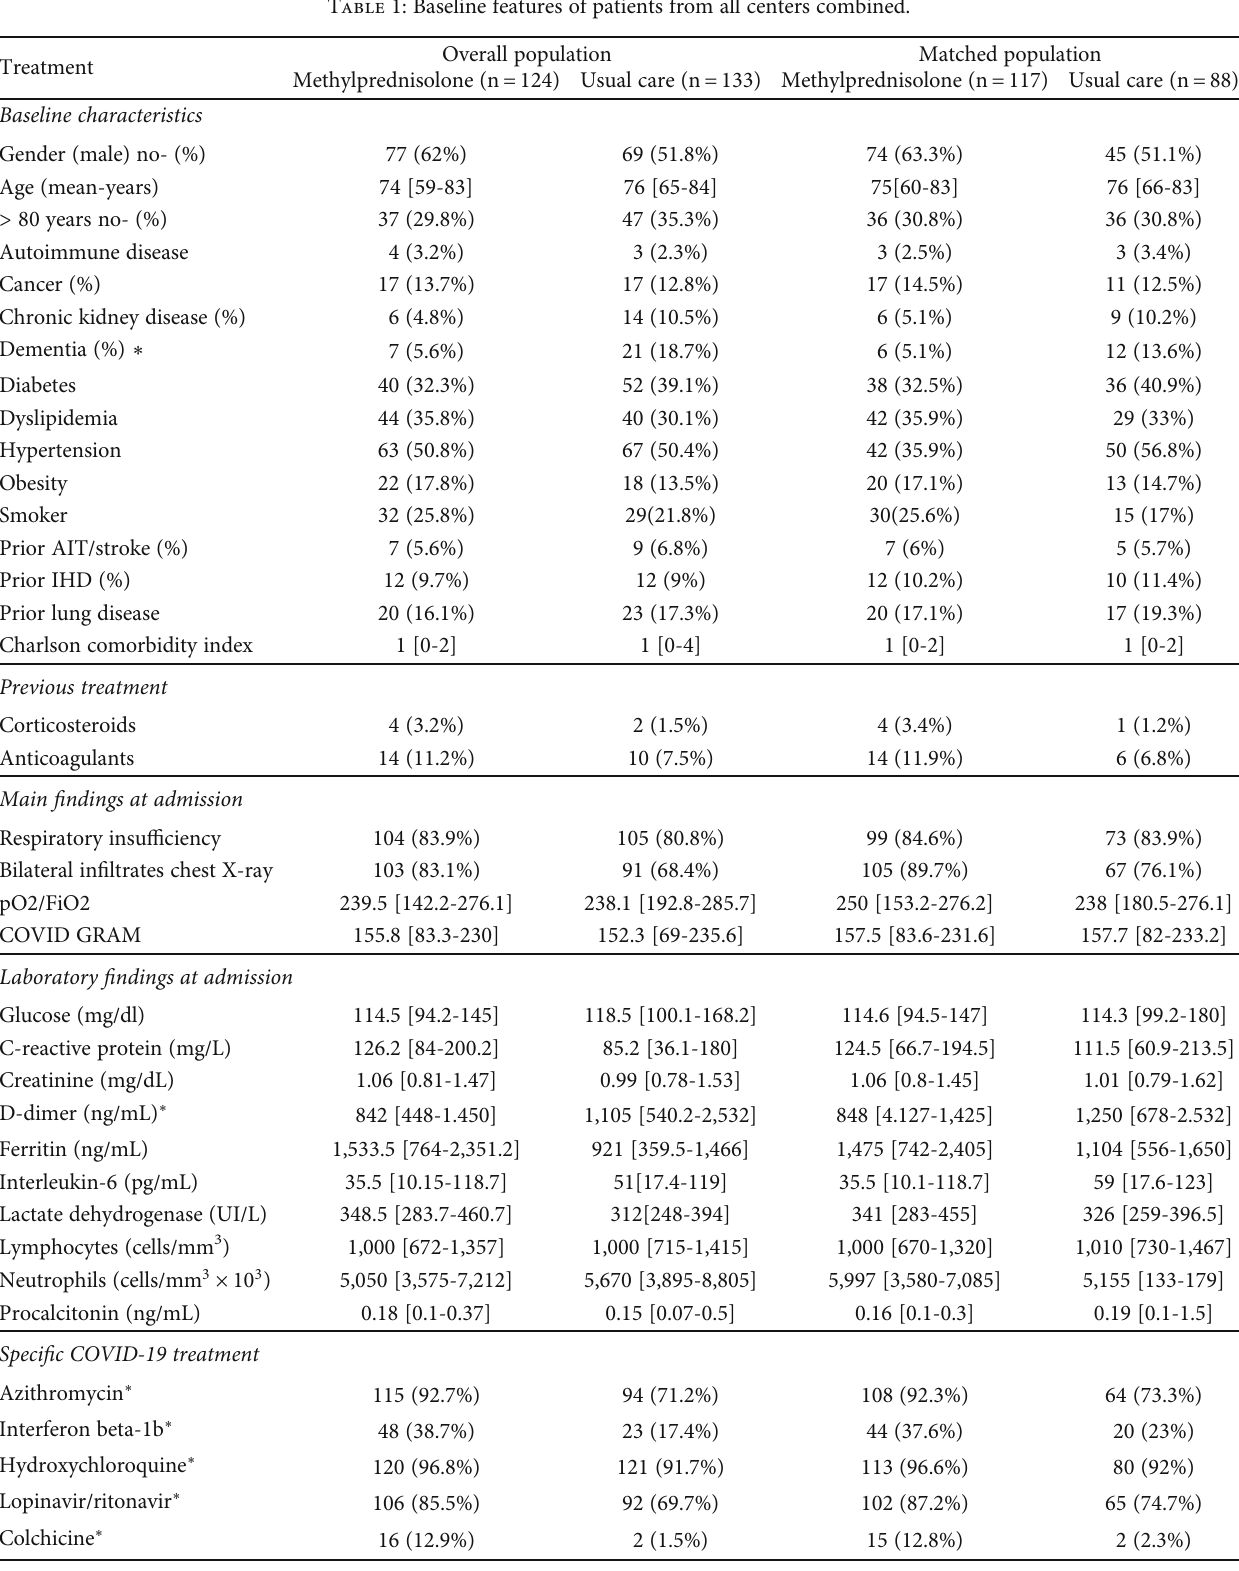
Table 1: Baseline features of patients from all centers